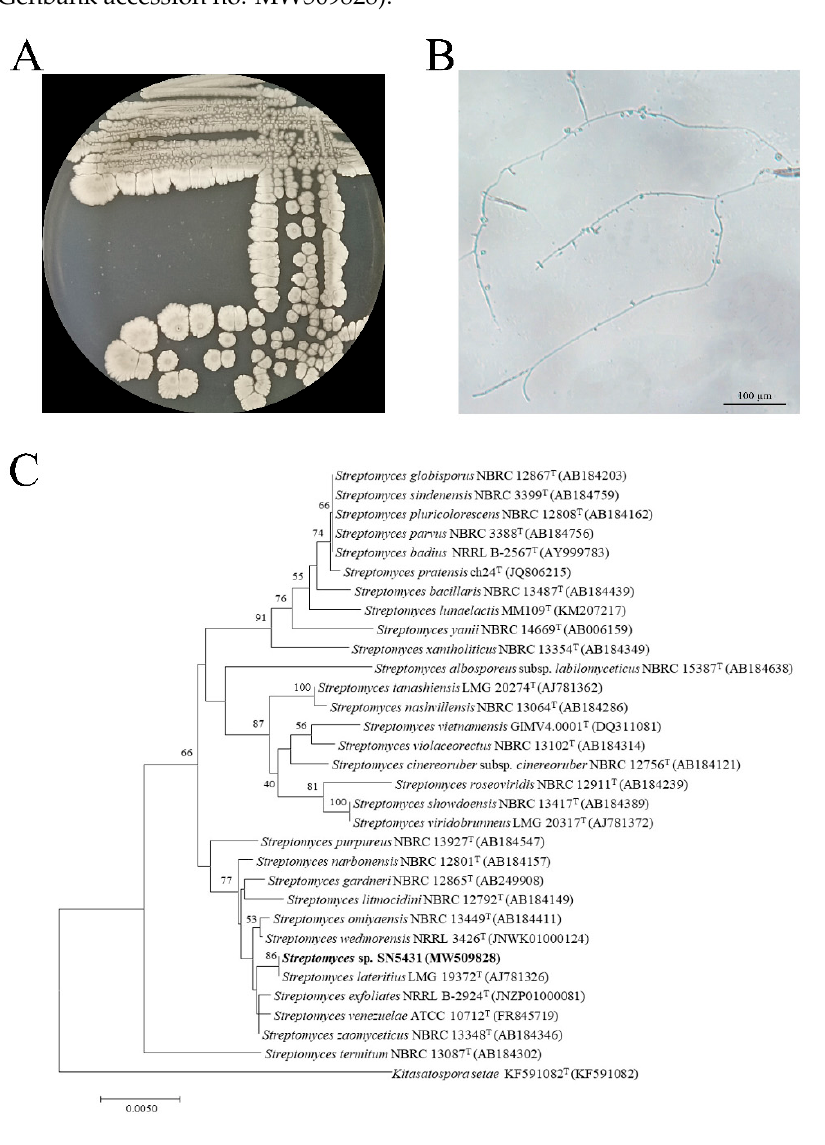
Figure 1. The identification of strain SN5431. ( A ) The colony morphology of strain SN5431 on GS medium. ( B ) The morphology of strain SN5431 on GS medium. ( C ) Neighbor-joining phylogenetic tree based on the 16S rRNA gene sequences with strain SN5431 and related members of the genus Streptomyces